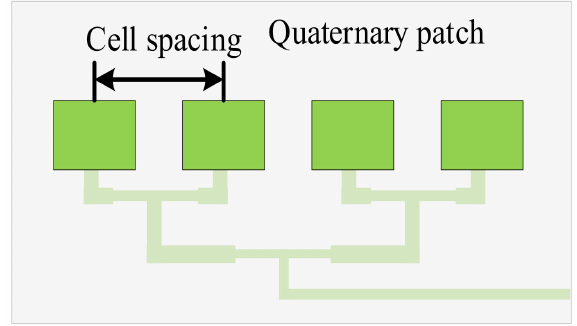
Figure 3. Microstrip antenna array model.